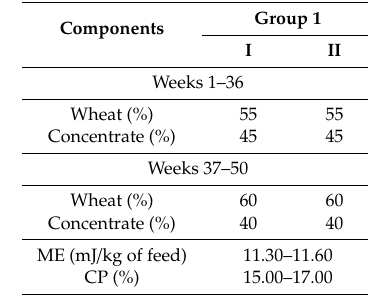
Table 2. Levels of feed components in hen diets and throughout the whole egg production period (50 weeks).